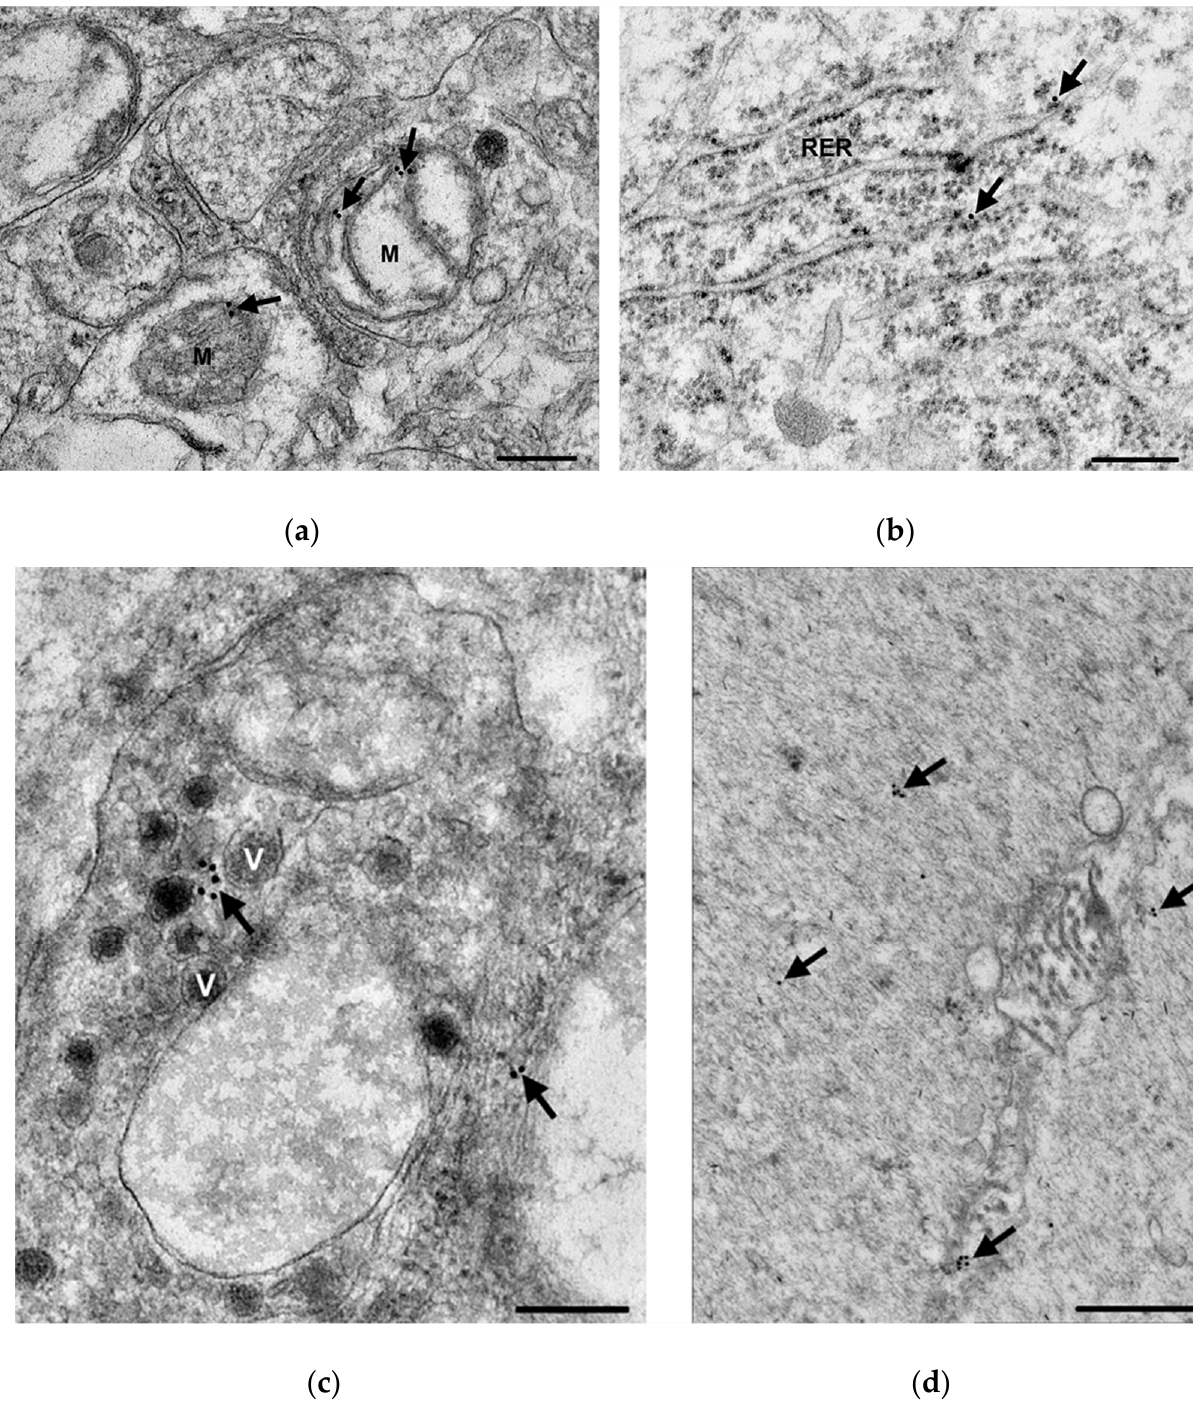
Figure 2. Representative electron micrographs of a portion of the ganglionic neuropil of the myenteric plexus in the duodenum ( a ) and the ileum ( c ) of a diabetic rat, a small detail of a perikaryon from the duodenum ( b ) of a diabetic rat and a part of longitudinal smooth muscle cells of intestinal wall from the colon ( d ) of a control rat after post-embedding immunohistochemistry, using a TNF α -specific antibody. The majority of the 18 nm gold particles labelling TNF α (arrows) were grouped and attached to the plasma membrane or intracellular membranes, and they were observed also in the mitochondria (M) (arrows in ( a )), in the vicinity of synaptic vesicles (V) (arrows in ( b )) and at cisternae of the rough endoplasmic reticulum (RER) (arrows in ( c )). Scale bars: 250 nm.